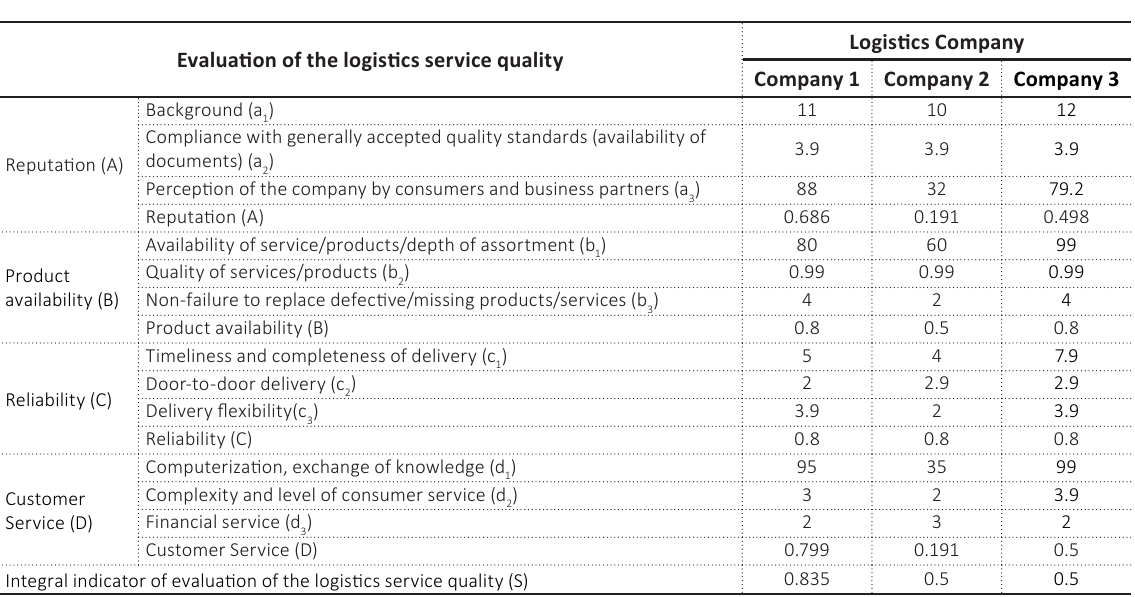
Figure 8 (cont). Implemented data defuzzification to the final level of the developed fuzzy model – an integral indicator of the quality of logistics service for Company No. 1 Table 4. Generalized input, intermediate parameters, and evaluation results of the integral indicator of the logistics service